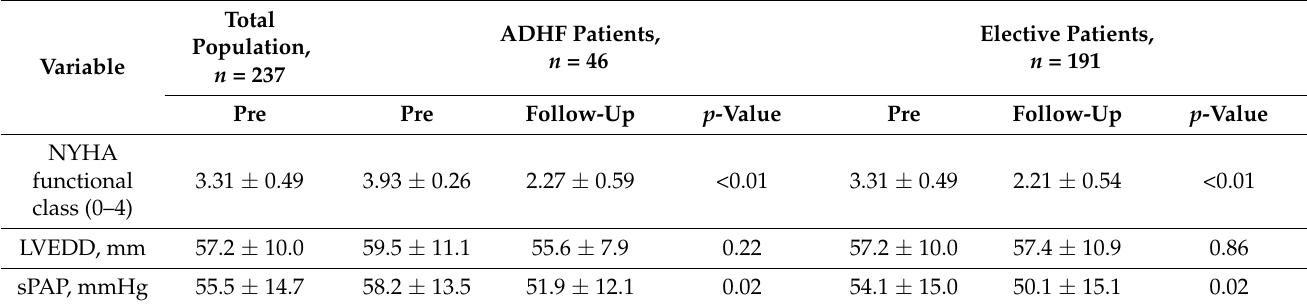
Table 6. Clinical and echocardiographic outcomes of patient population with severe MR underwent